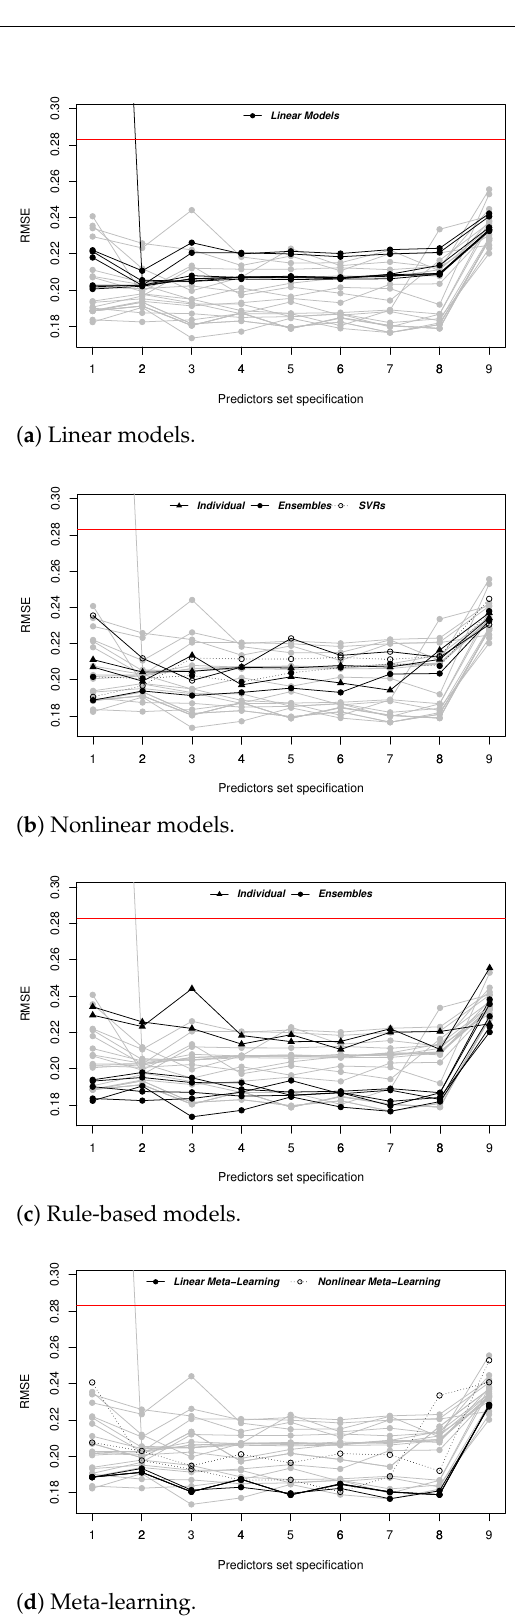
Figure 4. Illustration of forecasting performance across model specifications. The horizontal red line is the model based on the in-sample mean recovery rate. Panel ( a ) highlights the performance of linear models. Panel ( b ) highlights the performance of nonlinear models. Panel ( c ) highlights the performance of rule-based models. Panel ( d ) illustrates the performance of linear and nonlinear meta-learning